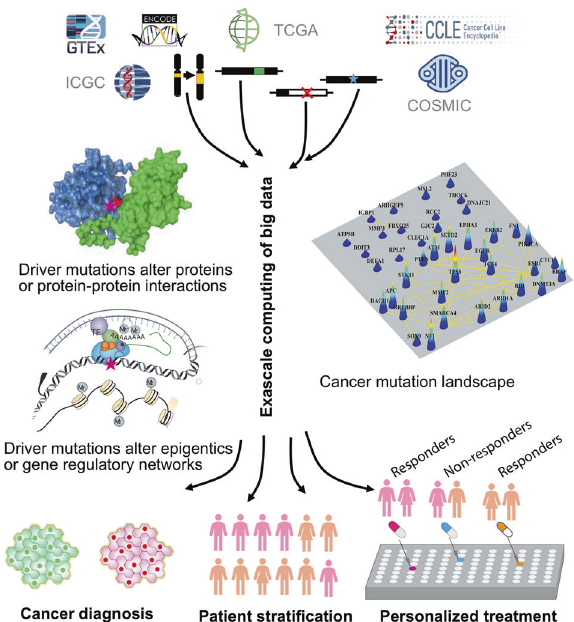
Fig. 5 A proposed atlas and its associated portal for precision cancer medicine using exascale computing of “ big ”